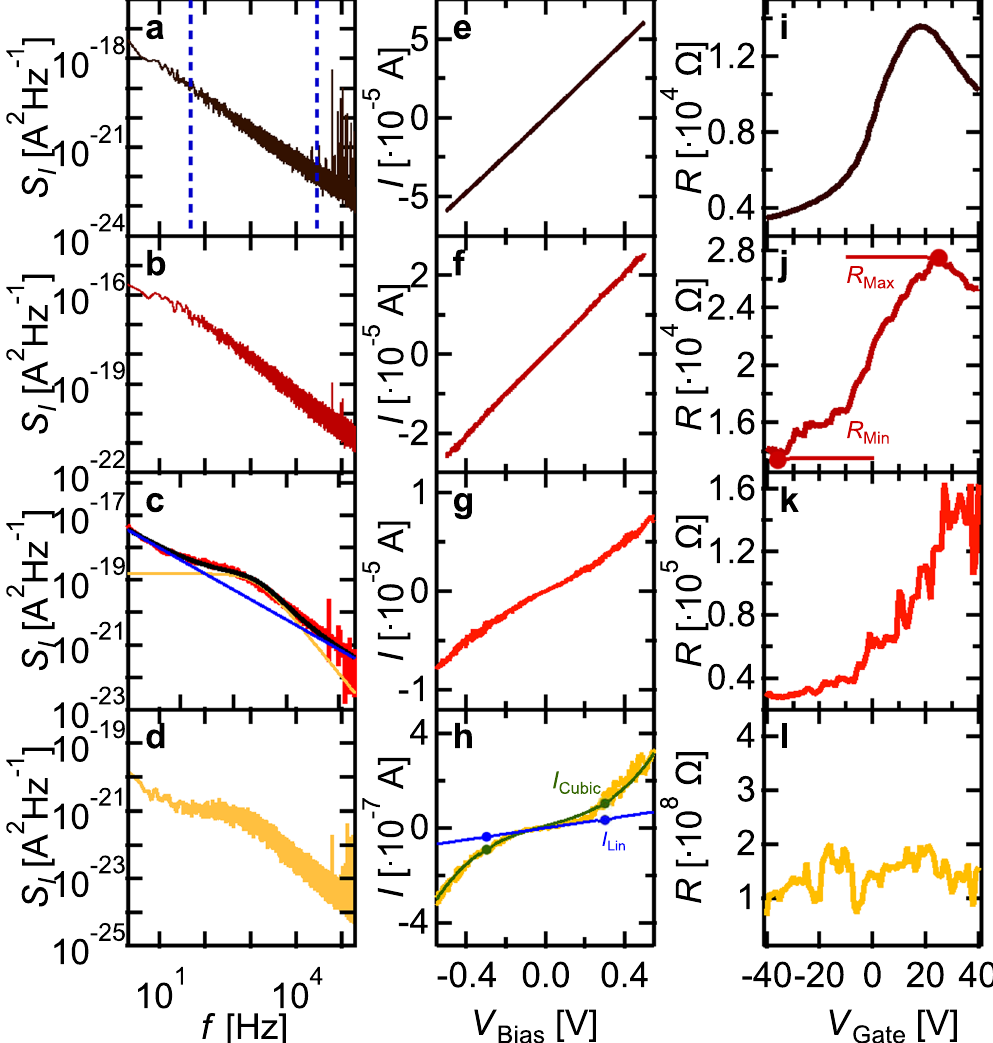
Fig. 2 Representative noise spectra, current-voltage characteristics and gate response curves at different stages of the electrical breakdown. a , b , c , d Power spectral density (PSD) plots, e , f , g , h I ( V ) and i , j , k , l gate response characteristics of graphene bow-tie devices in their initial state ( ≈ 8 k Ω , brown curves in a , e , i ), in an early stage of the EB ( ≈ 20 k Ω , dark red curves in b , f , j ), in the narrow nanojunction regime ( ≈ 40 − 60 k Ω , red curves in panels c , g , k ) and in the tunneling regime ( ≈ 50 − 150 M Ω , yellow curves in d , h , l ). The blue dashed lines in a illustrate the frequency band of our further analysis (see text). In c the fi tted 1/ f -type (blue line), Lorentzian (yellow), and total (black) noise contributions are illustrated (see text). The green and blue lines in h respectively illustrate the fi tted cubic and linear contributions to the I ( V ) curve, from which the degree of the I ( V ) nonlinearity is evaluated at 300 mV (see dots, and the detailed description in the text). In j the maximum (R Max ) and minimum ( R Min ) resistance is marked in the ±40 V gate voltage window, which are used for the calculation of the relative gate response amplitude (see text). Throughout our analysis, the noise spectra and the I ( V ) curves are measured at zero gate